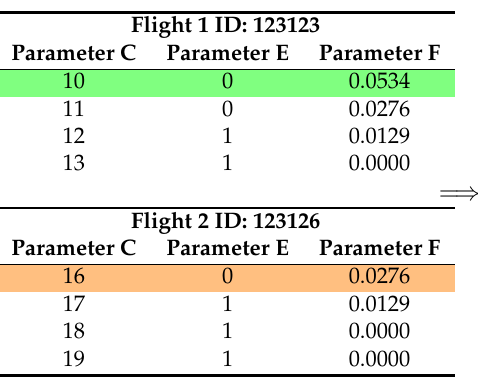
Table 6. Notional feature vector matrix assembly for single